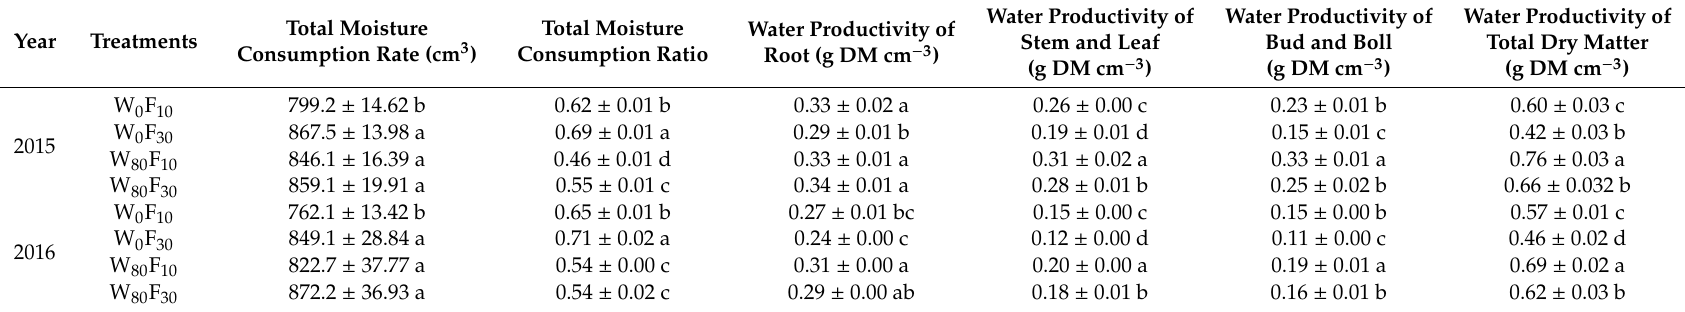
Table 3. Change of total moisture consumption rate, total moisture consumption ratio, water productivity of root, water productivity of stem, leaf, water productivity of bud plus boll and water productivity of total dry matter under di ff erent irrigation and fertilization during 2015 and 2016.